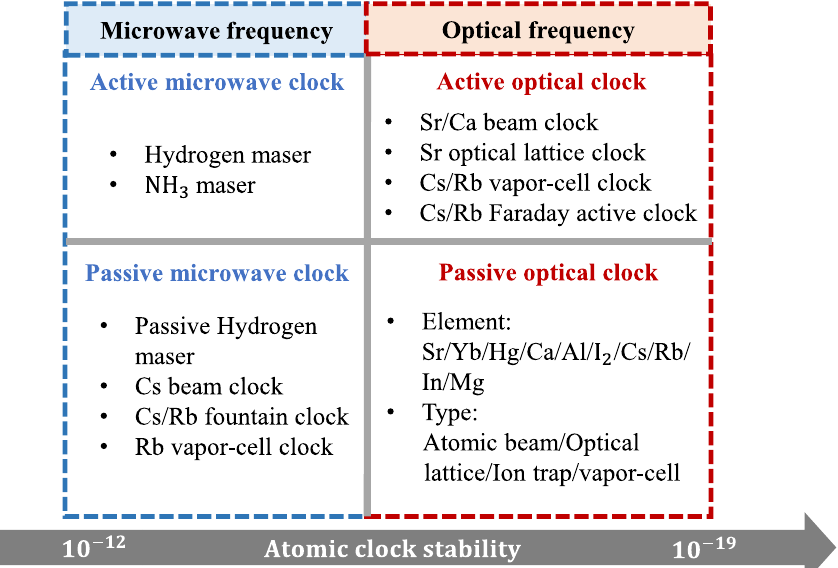
Fig. 1 Classification of atomic clocks. According to the frequency band, atomic clocks can be divided into microwave clocks and optical clocks. Atomic clocks also can be divided into two categories according to their working mode, namely passive clocks and active